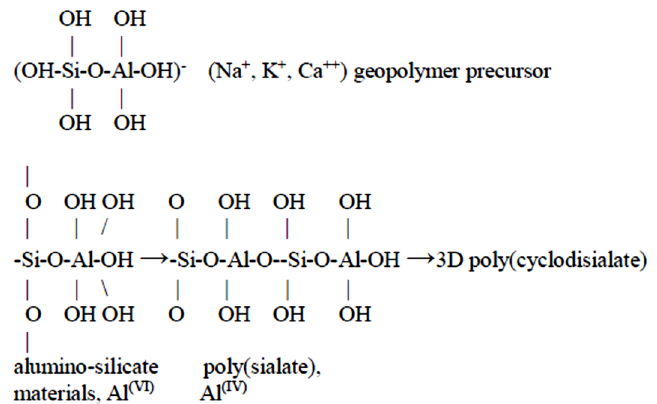
Figure 1. Cross-linking of LTGS geopolymeric reaction.